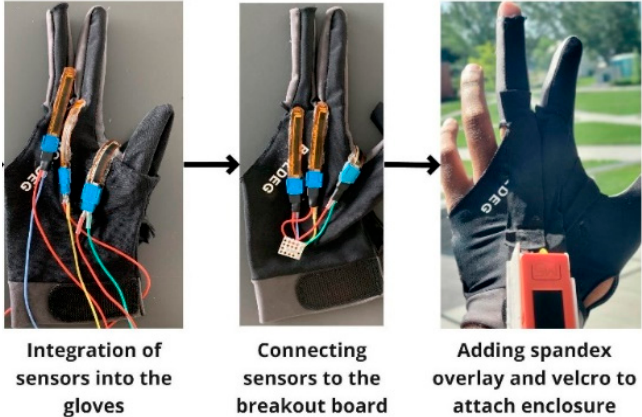
Figure 3. Assembly process for iTex glove.